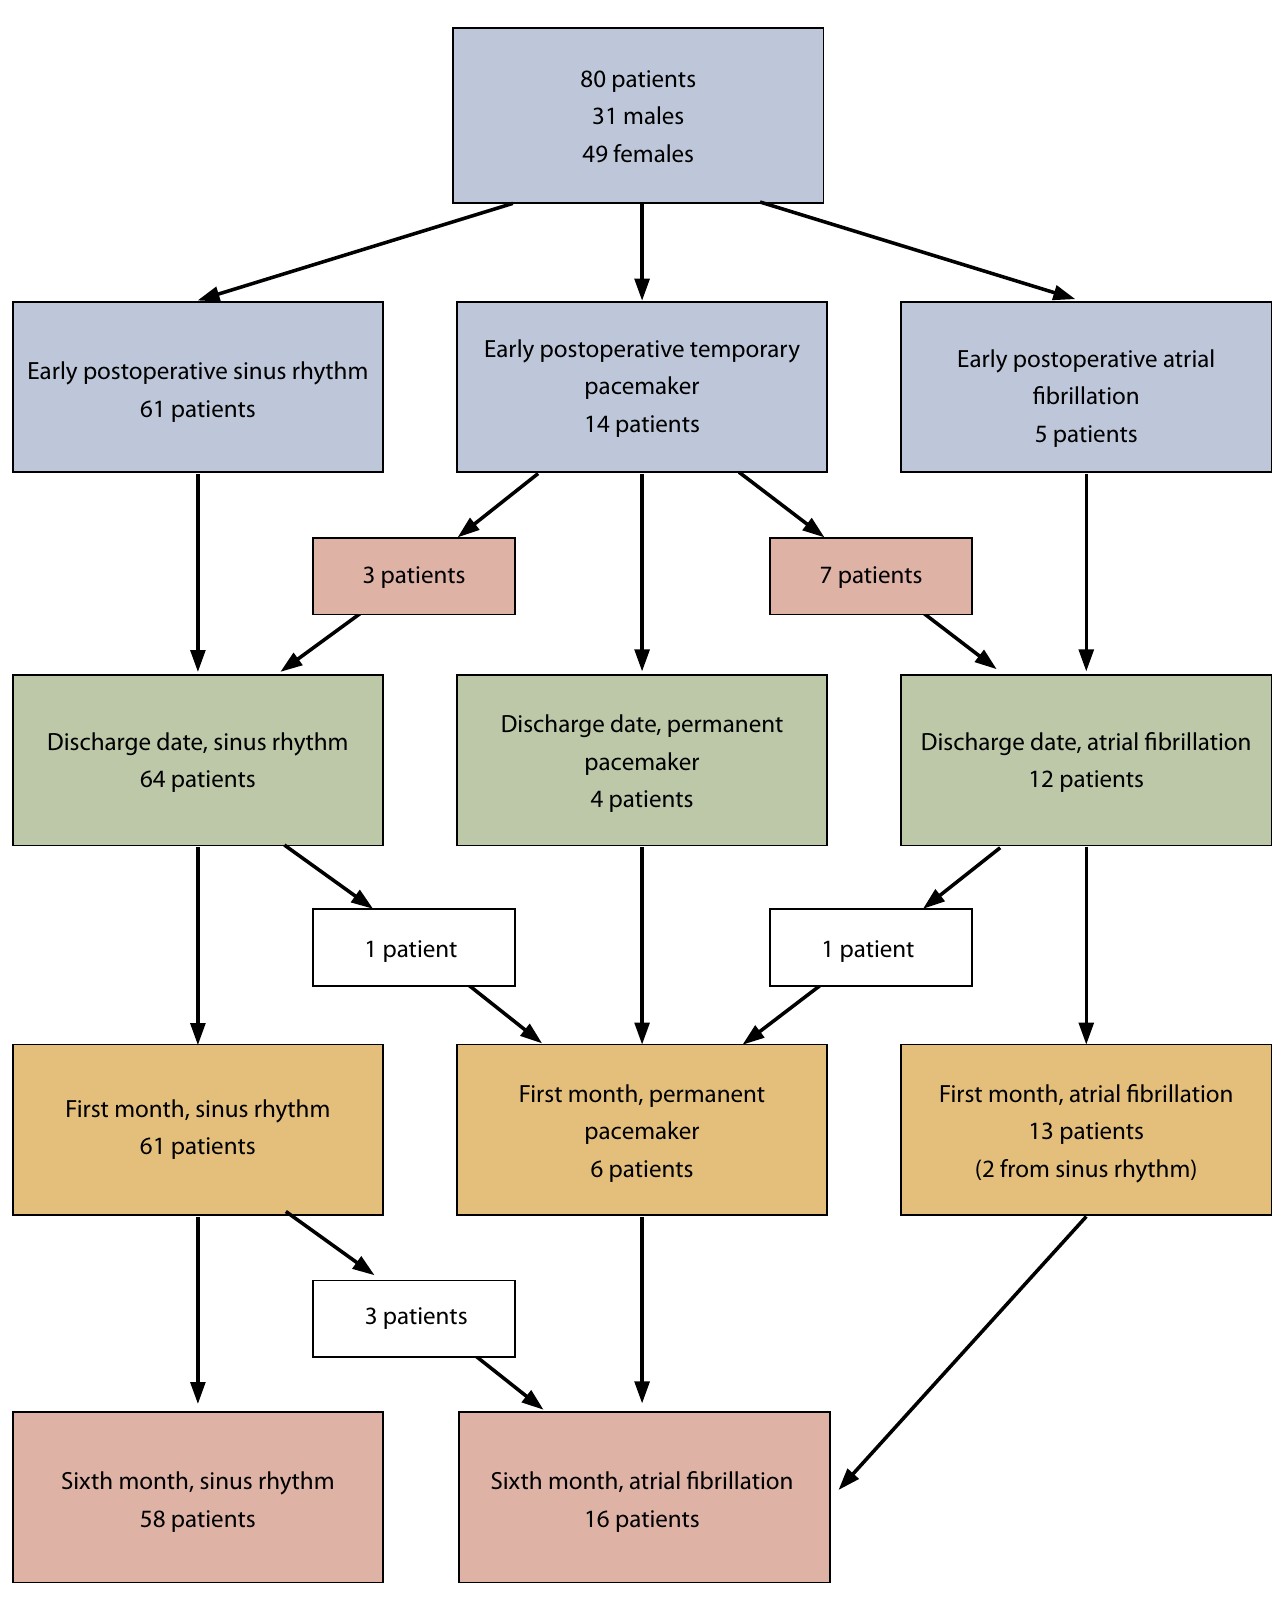
Fig. 2 – Summary of